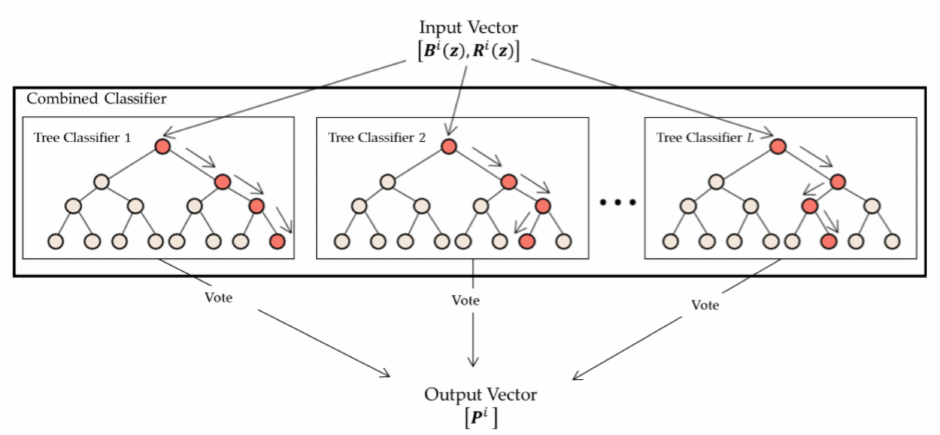
Figure 6. Overall structure of the combined classifier for the source location